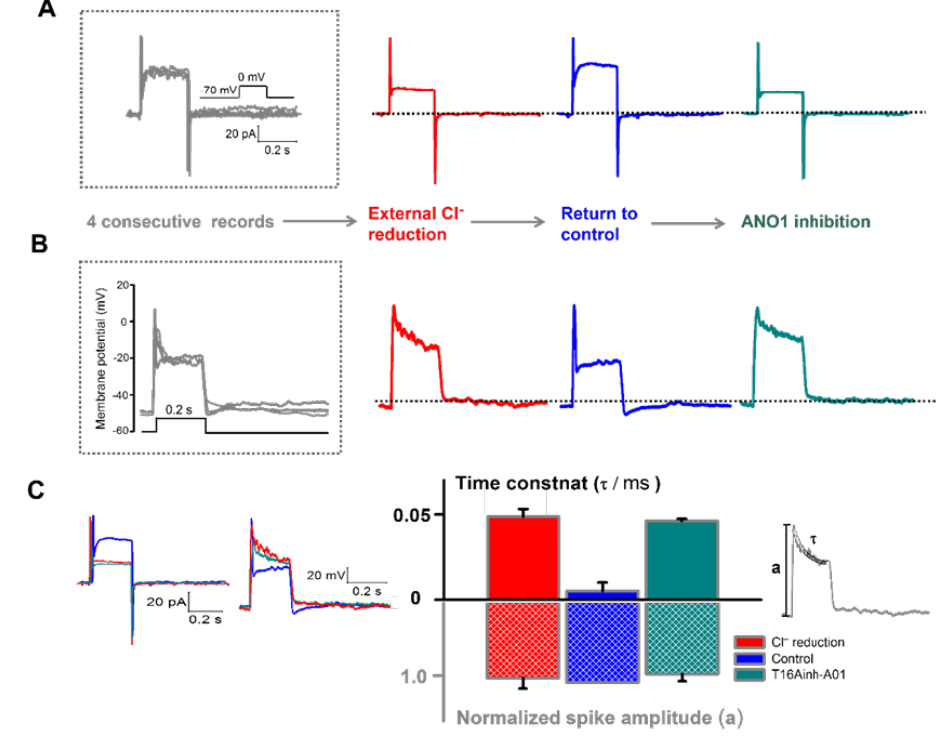
Figure 3. The voltage-dependent component of ANO1 is involved in the rapid decay of the initial phase of the waveform. ( A ) Four consecutive voltage-clamp recordings (10 mV intervals from − 70 mV holding potential for 250 ms) were performed to determine the control condition of the bipolar cells lacking I tail . From the control condition (gray), the responses were detected by changing the extracellular solutions in this order: low Cl − , control, and with T16Ainh-A01. ( B ) After switching to the current-clamp mode, the control waveforms (gray) and cell membrane potential were detected using the same process. The cells were depolarized by current injection ( ≈ 20 pA) from a resting potential of approximately − 50 mV. Representative traces are shown in red (low Cl − ), blue (control), and dark cyan (T16Ainh-A01). ( C ) The traces obtained from the two modes are superimposed to compare the di ff erences between the outward current component and the decay of the initial potential phase. The decay time constant τ was obtained from the single exponential fit of the initial phase of the waveform. Each amplitude spike was measured and shown in the inset. The time constant in the decay phase (top row) compared with the normalized spike amplitude (bottom row) was represented by a bar graph for each condition. The results were normalized by setting the maximum value as 1 ( n = 10, p < 0.05, ANOVA, τ red = 0.048 ± 0.0046 ms, τ blu e = 0.0051 ± 0.0049 ms, τ dark cyan = 0.046 ± 0.0012 ms; a red = 0.94 ± 0.13, a blue = 1, a dark cyan = 0.90 ± 0.89; n = 6, error bars represent S.E.M).